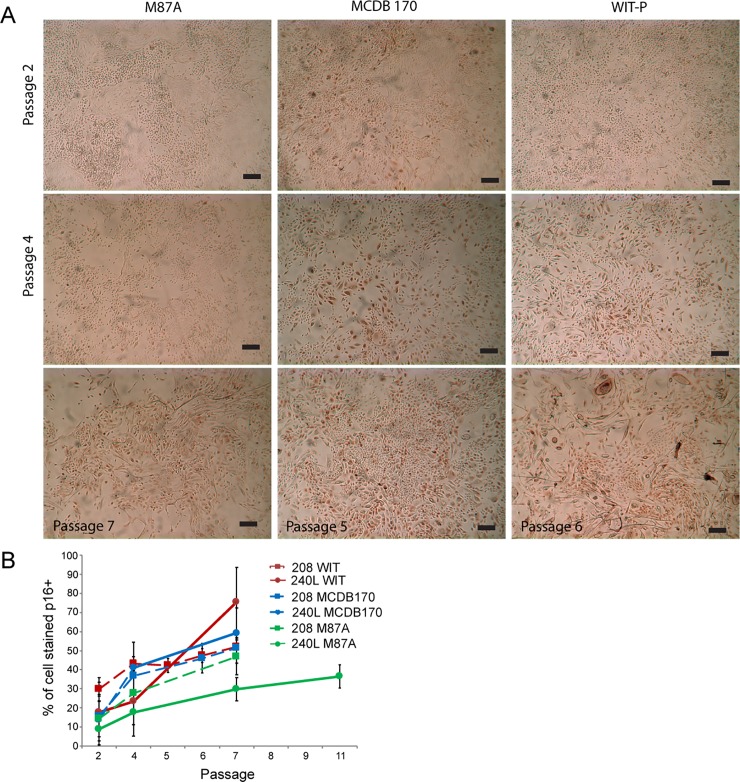
Immunohistochemical examination of p16 protein expression in pre-stasis HMEC 240L in three different growth media.(A) The presence of p16 protein is detectable by brown-colored precipitate formed by horse radish peroxidase reactions. Images are shown of HMEC 240L grown in M87A, MCDB 170, and WIT-P at 2p and 4p. Cells in MCDB 170 and WIT-P are shown also at p6 and p5, respectively, because both of those media cause significant number of p16+ cells as early as those passages, whereas M87A is shown at 7p. Bars represent 100μm. (B) Line graphs showing quantification of percent p16 stained cells/total as a function of passage for strain 240L (solid line) and 208 (dashed line) cultured in M87A (green), MCDB 170 (blue), or WIT-P (red). From 3–12 images of each specimen at the indicated passages in all three media were counted. Areas under the curve (AUC) are reported for each media (240L,208): M87A (97.0, 153.7), MCDB 170 (205.4, 183.7), WIT-P (189.1, 209.9).